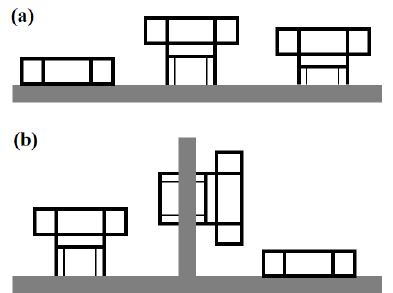
Figure 2. Screws in a complex environment. ( a ) Screws under different loose states located on the same surface. ( b ) Screws located on different